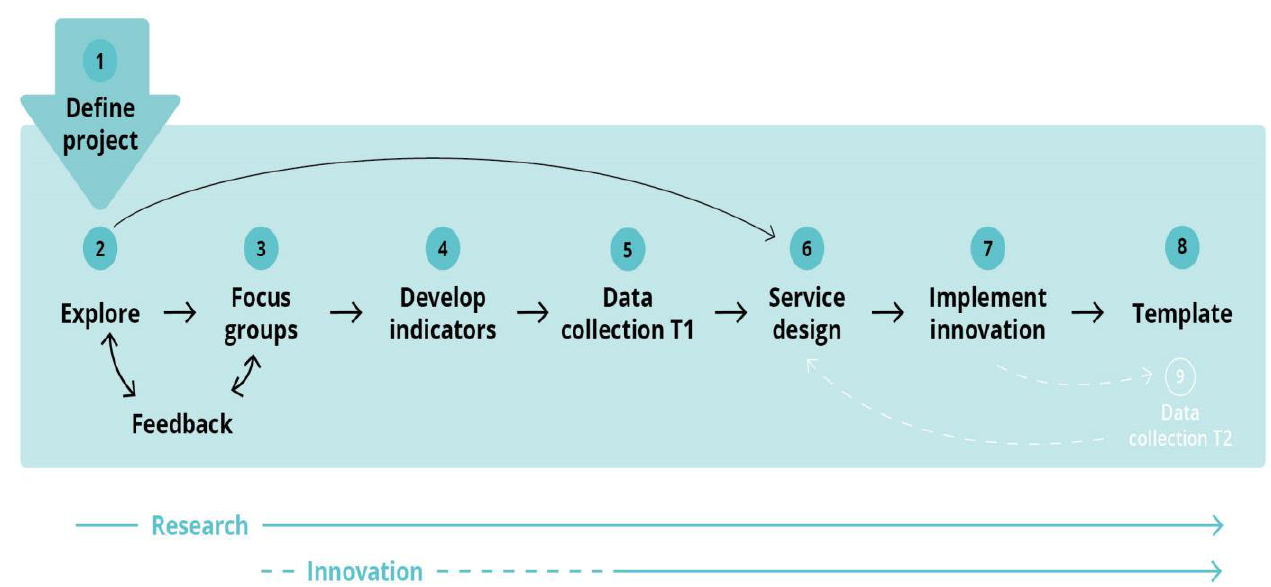
Figure 1. Research and innovation cycle in this project.